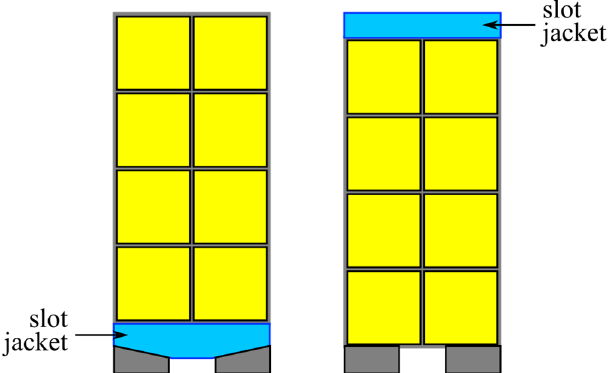
Figure 17. Various slot water jacket designs [103]. The slot water pipes are marked with turquoise.